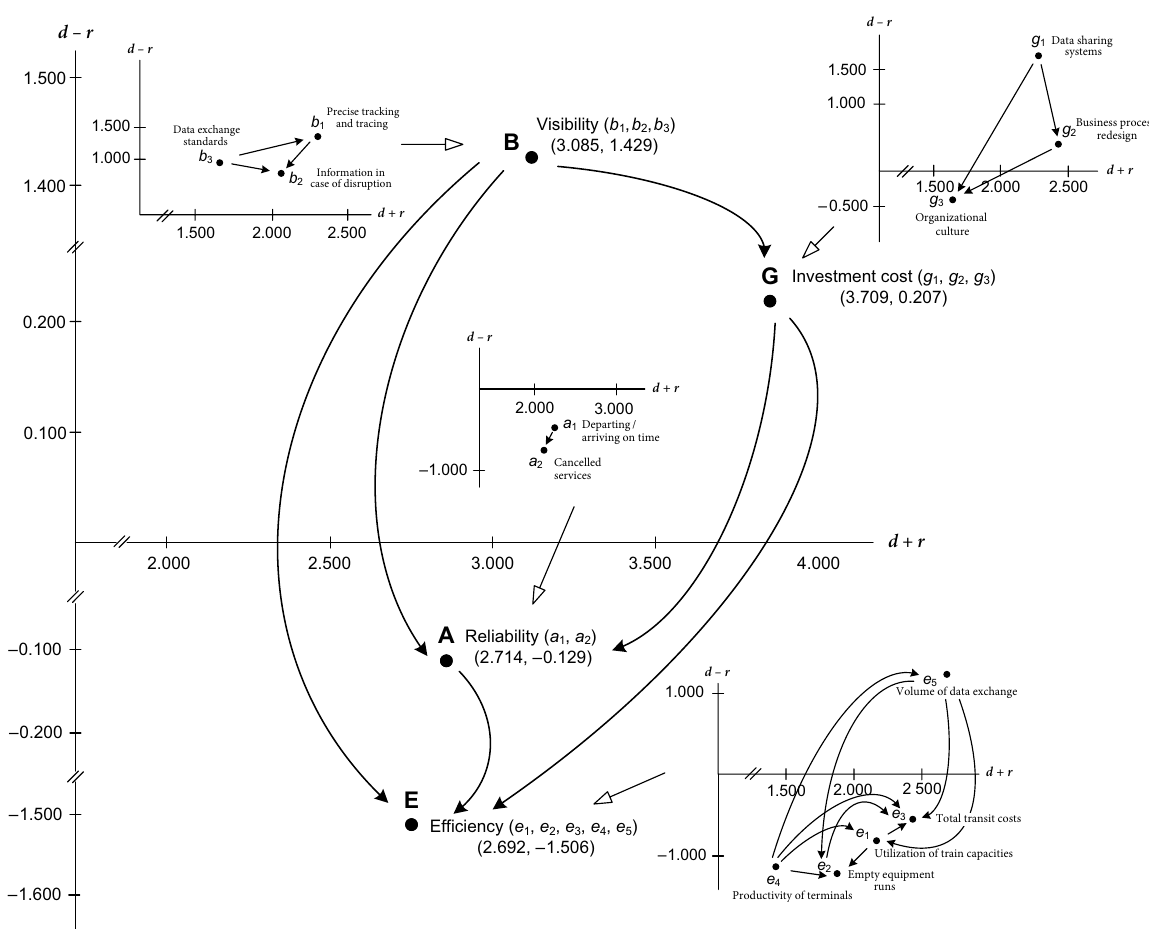
Figure 10. Causal diagram of total relationships: terminal operators’